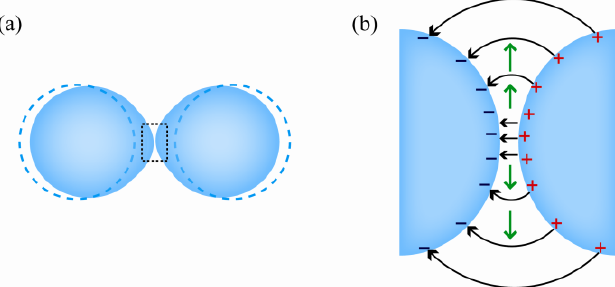
Figure 12. Two approaching droplets in an electric field. ( a ) Deformation from a sphere to a prolate spheroid occurs due to the electrical stress; ( b ) Close up showing local surface charges of opposite sign. Black arrows indicate the electric field. Green arrows indicate how ambient oil is squeezed out.